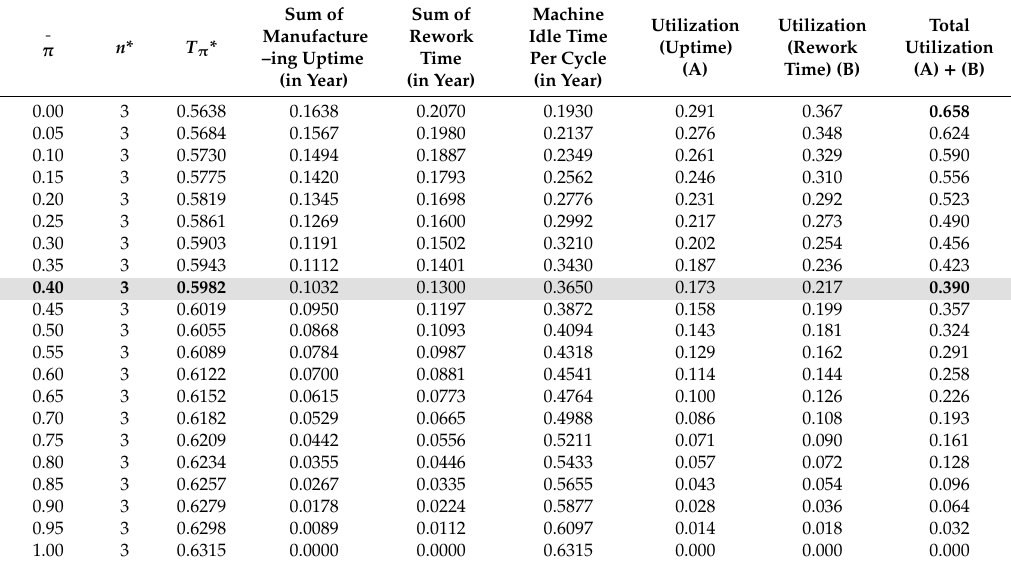
Table A2. Impacts of changes in π on sum of uptime, rework time, and